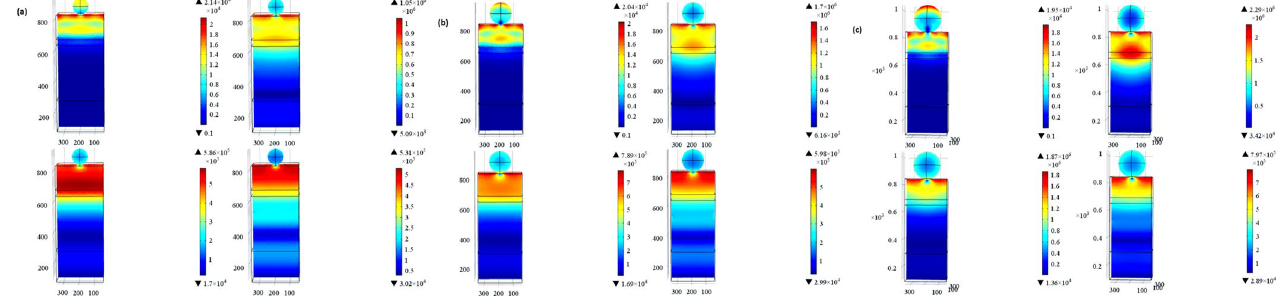
Figure 3. Electric field profiles at different wavelengths: ( a ) 300 nm, ( b ) 800 nm, ( c ) 1000 nm, and (id) 1200 nm for ( a ) 50 nm, ( b ) 75 nm, and ( c ) 100 nm TiN nanoparticles-decorated PSCs, respectively.